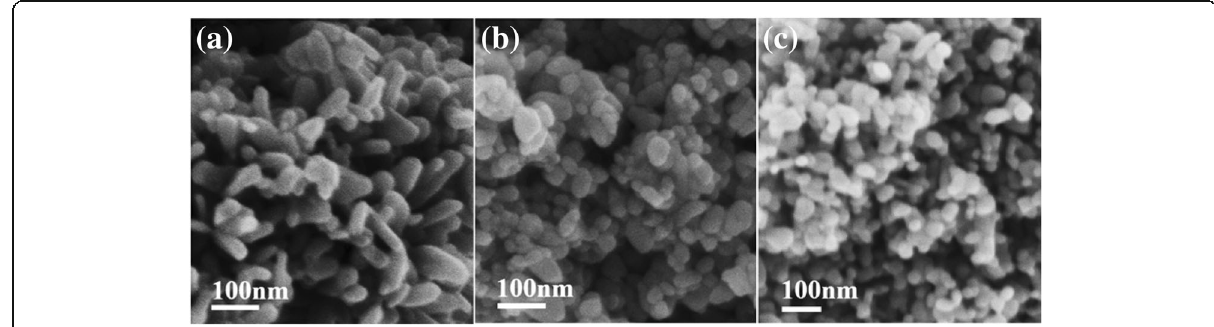
Fig. 6 SEM images of ZnO nanoparticles obtained from the different concentration of ZnCl 2 aqueous solution under the 1:1 of mole ratio of glycerol to Zn 2+ ( a , 50 wt%; b , 65 wt%; c , 80 wt%)